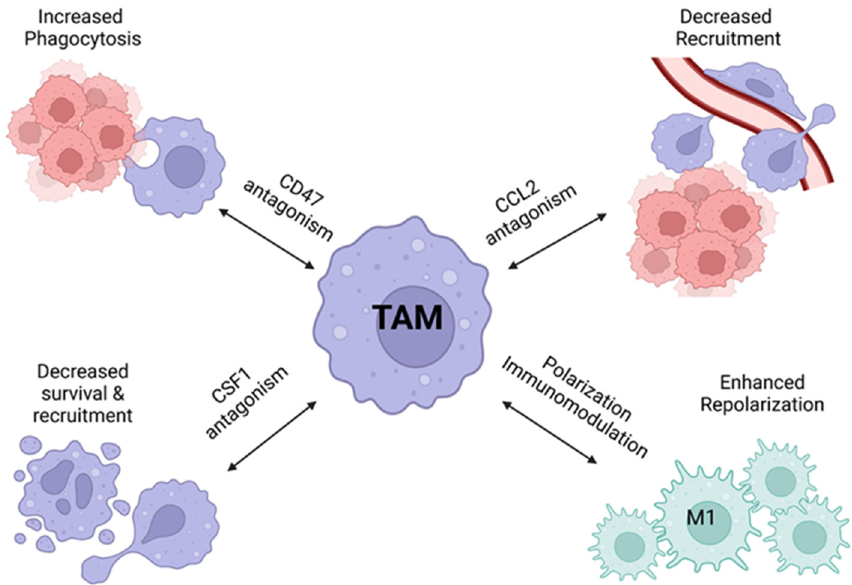
Figure 3. Anti-TAM therapeutic strategies. Created with BioRender.com. Accessed on 14 March